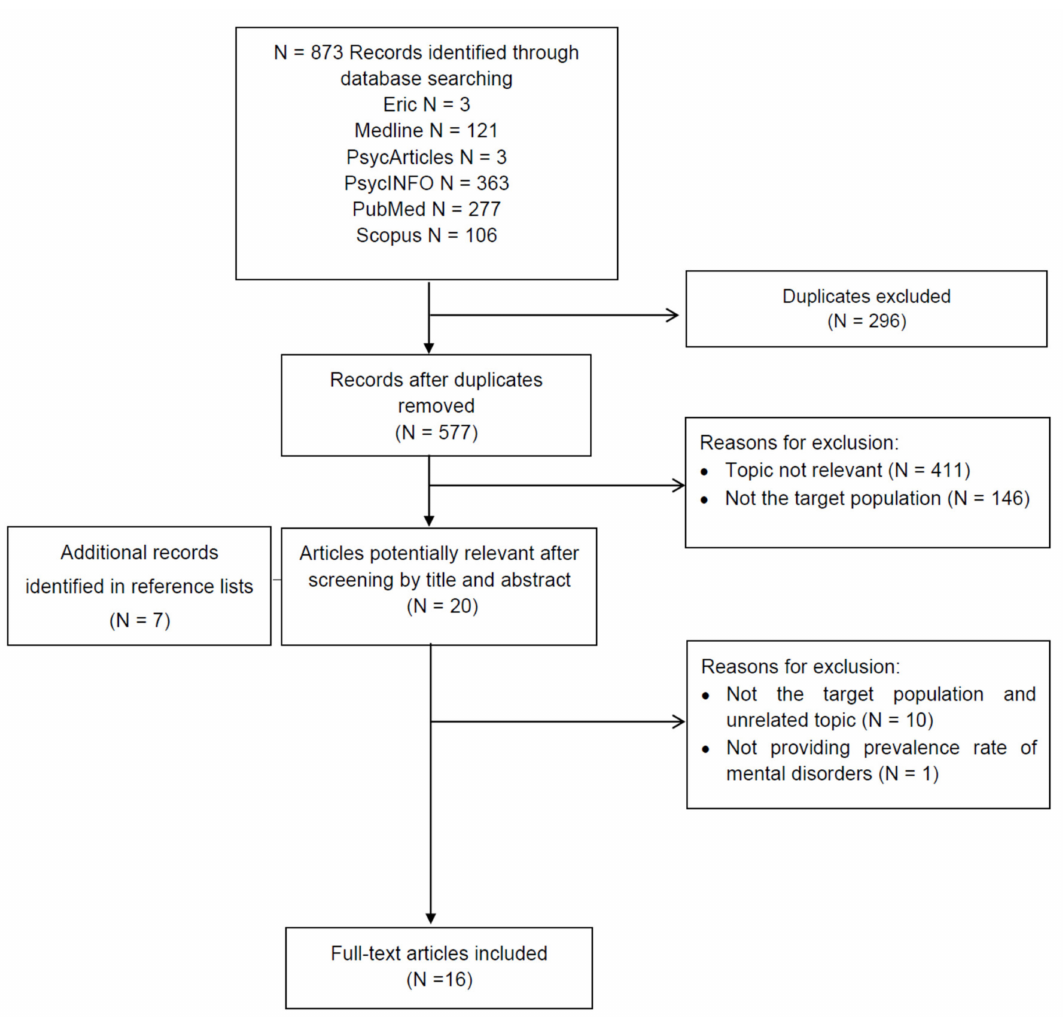
Figure 1. PRISMA